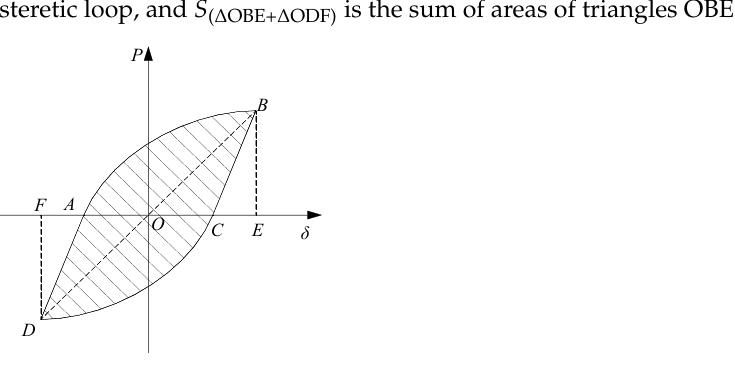
Figure 17. Calculating diagram of the equivalent viscous damping ratio. All specimens subjected to lateral shear exhibited pinching hysteretic loops (Figure 18), and their energy dissipation capacities were low. At the peak load, i.e., a drift ratio of approximately 1%, the equivalent viscous damping ratios of all specimens ranged from 0.12 to 0.2. The relative parameters, including the slit type, concrete strength, and height-to-span ratio, slightly influenced the hysteretic loop shape and energy dissipation capacity of the RC panel. Therefore, when the RC panels are used to retrofit an existing or damaged structure, the main objective is to increase the lateral strength and stiffness.